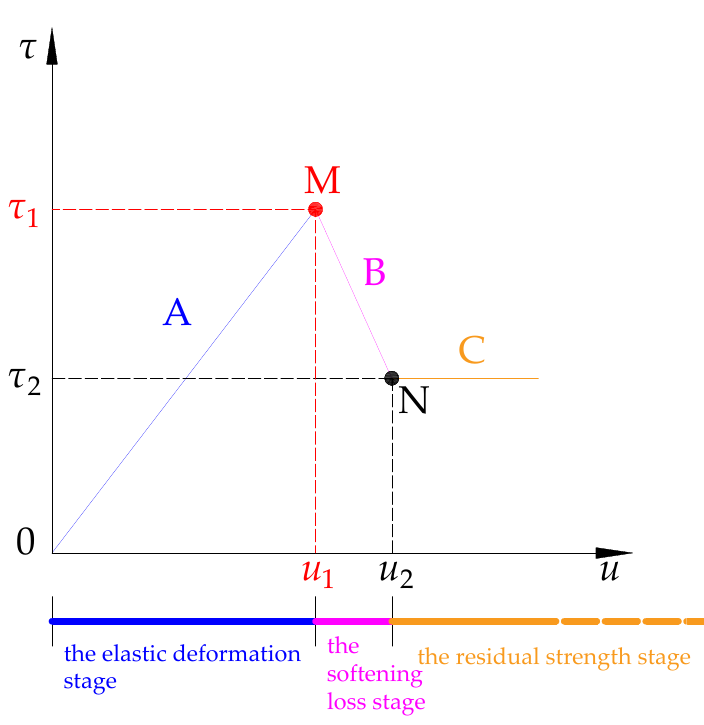
Figure 1. Shear stress–displacement relationship of anchoring body.